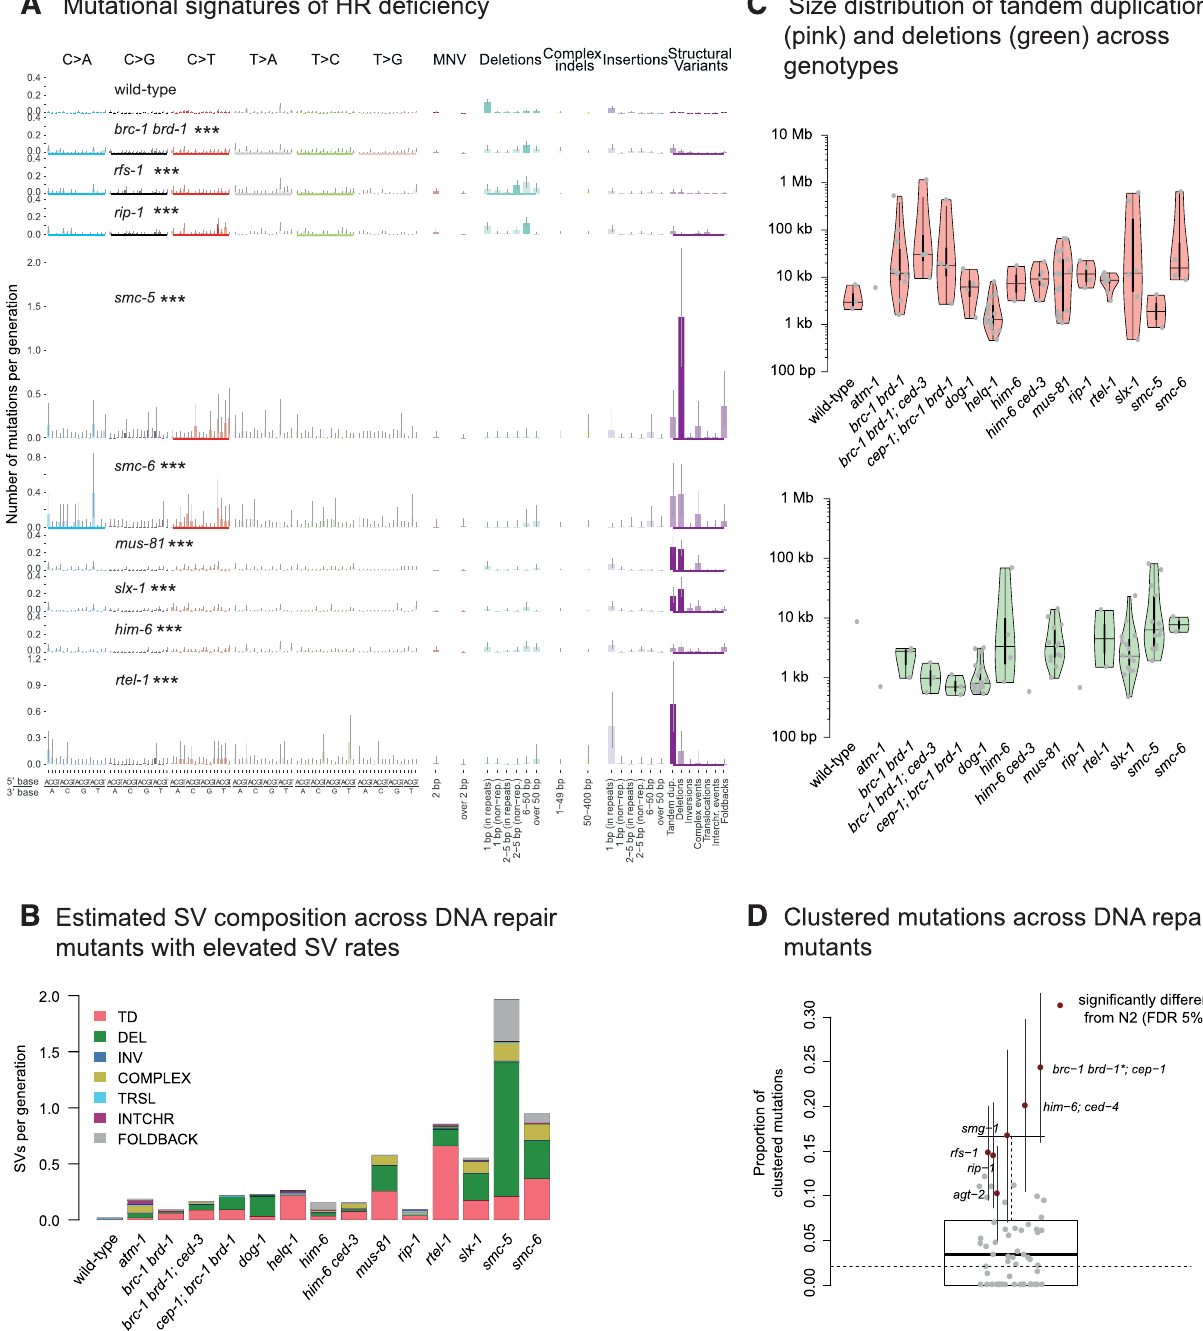
Fig 4. Mutational signatures and genomic features of mutations in DSBR deficient C . elegans . A. Mutational signatures of DSBR mutants that exhibited statistically significant different mutation rates to wild-type displayed in numbers of mutations per generation. Bold coloured bars denote individual mutation classes where the number of mutations is different from wild-type, an underscore below each mutation profile indicates mutation types with total mutation numbers different from wild-type, and three stars indicate genotypes which have rates of substitutions, indels or SVs significantly different compared to wild-type (FDR < 5%). B. Estimated composition of structural variants per generation as estimated for wild-type and DNA repair mutants with elevated SV rates. C. Size distributions of tandem duplications (top, pink) and deletions (bottom, green) across wild-type and mutants with elevated SV rates. D. Clustering of mutations in DNA repair deficient mutants. Grey dots reflect the average proportions of clustered mutations. Error bars denote 95% confidence intervals. Mutants with a significantly different propensity for mutation clustering from wild-type (dotted black line) are shown and highlighted in red. ‘Information related to the 528 whole genome sequencing WGS primary-source datasets (56 deposited in this study, 472 deposited in (Suppl Data 1 and Supple Note 1 of [10] can be found in S1